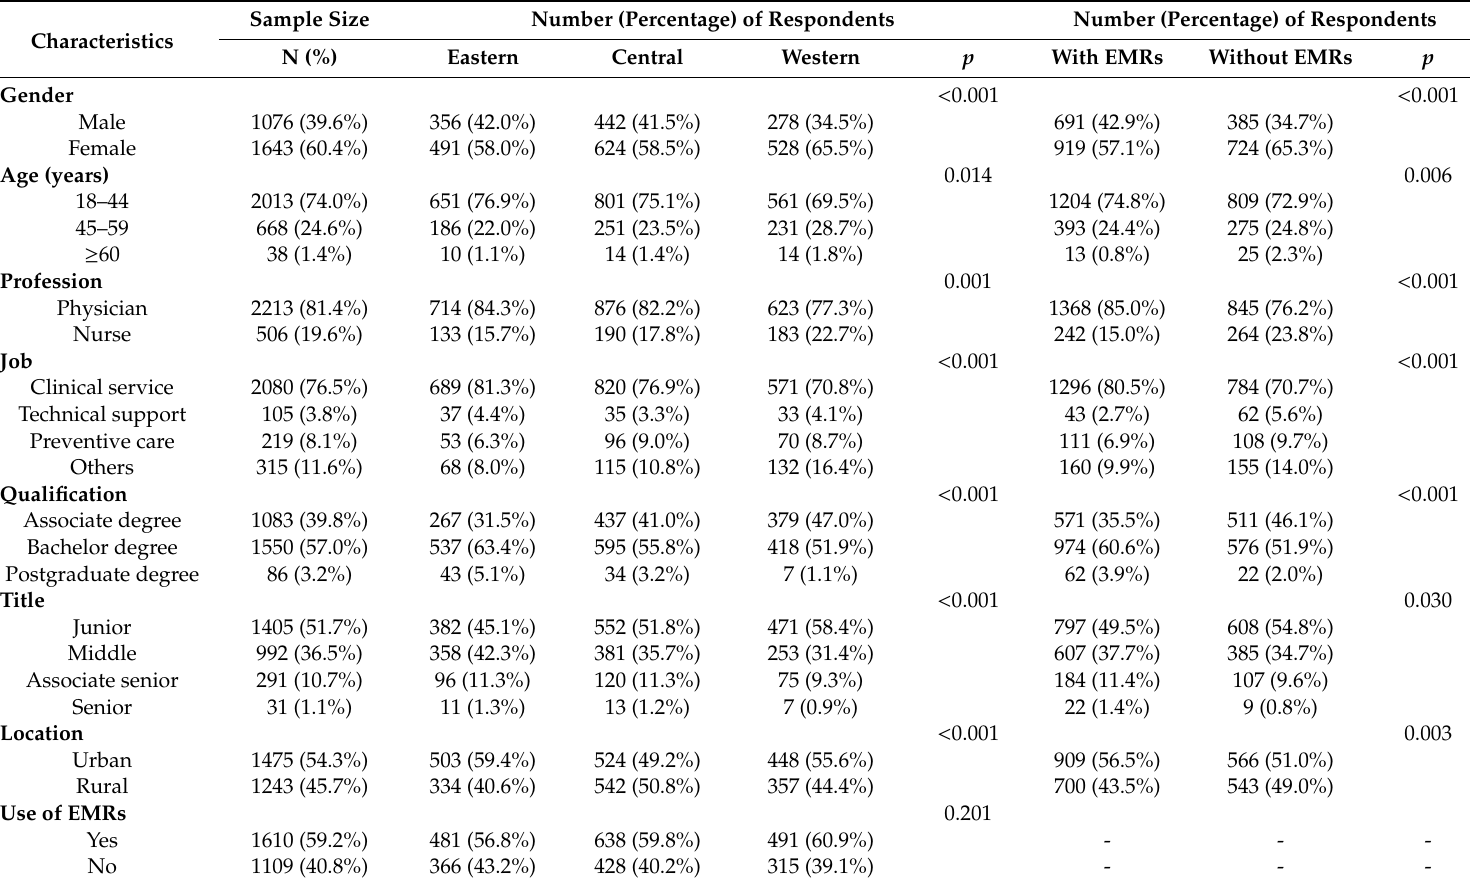
Table 1. Socio-demographic characteristics of